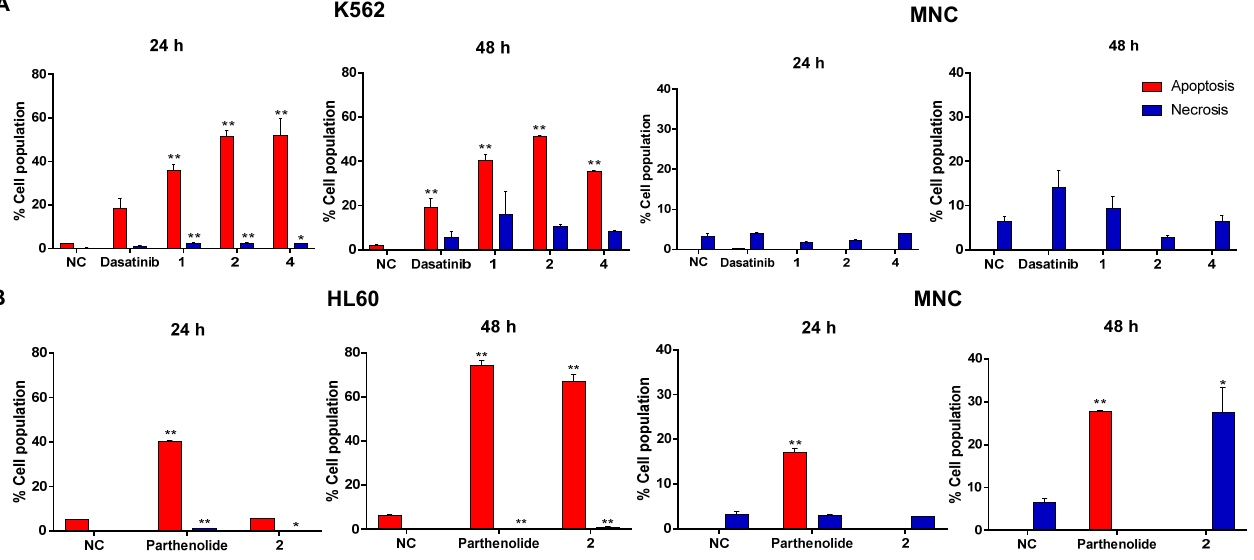
Figure 4. The compounds 1 , 2 , and 4 induced apoptosis in K562 and compound 2 in HL60. The compounds 1 (50 µg/mL), 2 (25 µg/mL), and 4 (100 µg/mL) were evaluated in cell line K562 and normal MNC. The results in ( A ) represents mean ± SEM of at least three independent experiments in cell line K562 and normal MNC, and results in ( B ) represents mean ± SEM of at least three independent experiments in cell line HL60 and normal MNC of compound 2 (100 µg/mL). Statistical significance was determined by a one-way analysis of variance (ANOVA) followed by Dunnett’s post-hoc test . The differences were considered significant at * p < 0.05, ** p < 0.01 compared to negative control.